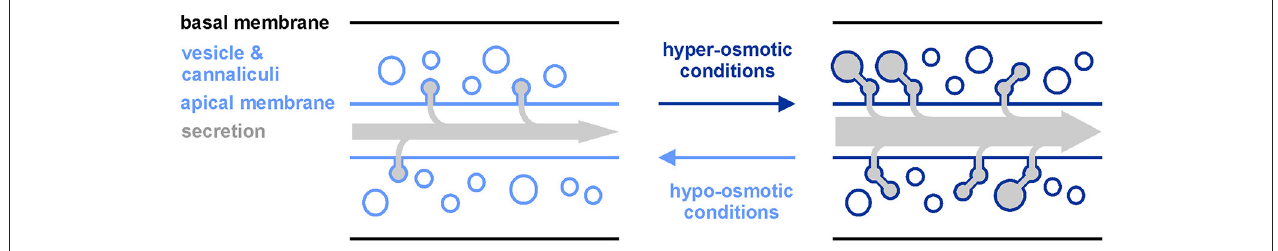
FIGURE 4 | Model of aqp-8 induced changes in excretory canal network upon alterations in the surrounding osmolarity. Upon exposure to hyper-osmotic conditions, aqp-8 expression is activated and enables more vesicles and canaliculi to attach to the excretory canal lumen. Thereby, excretes from vesicles are delivered into the canal lumen and the surface of the lumen is expanded to facilitate further secretion/excretion via the canal membrane. Hypo-osmotic conditions should have the reverse effect on the excretory canal network and the secretion/excretion capacity.